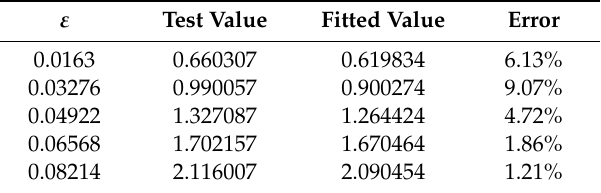
Table 7. The deviation between the tested stress and the fitted stress for specimen 1 under 400 ◦ C.